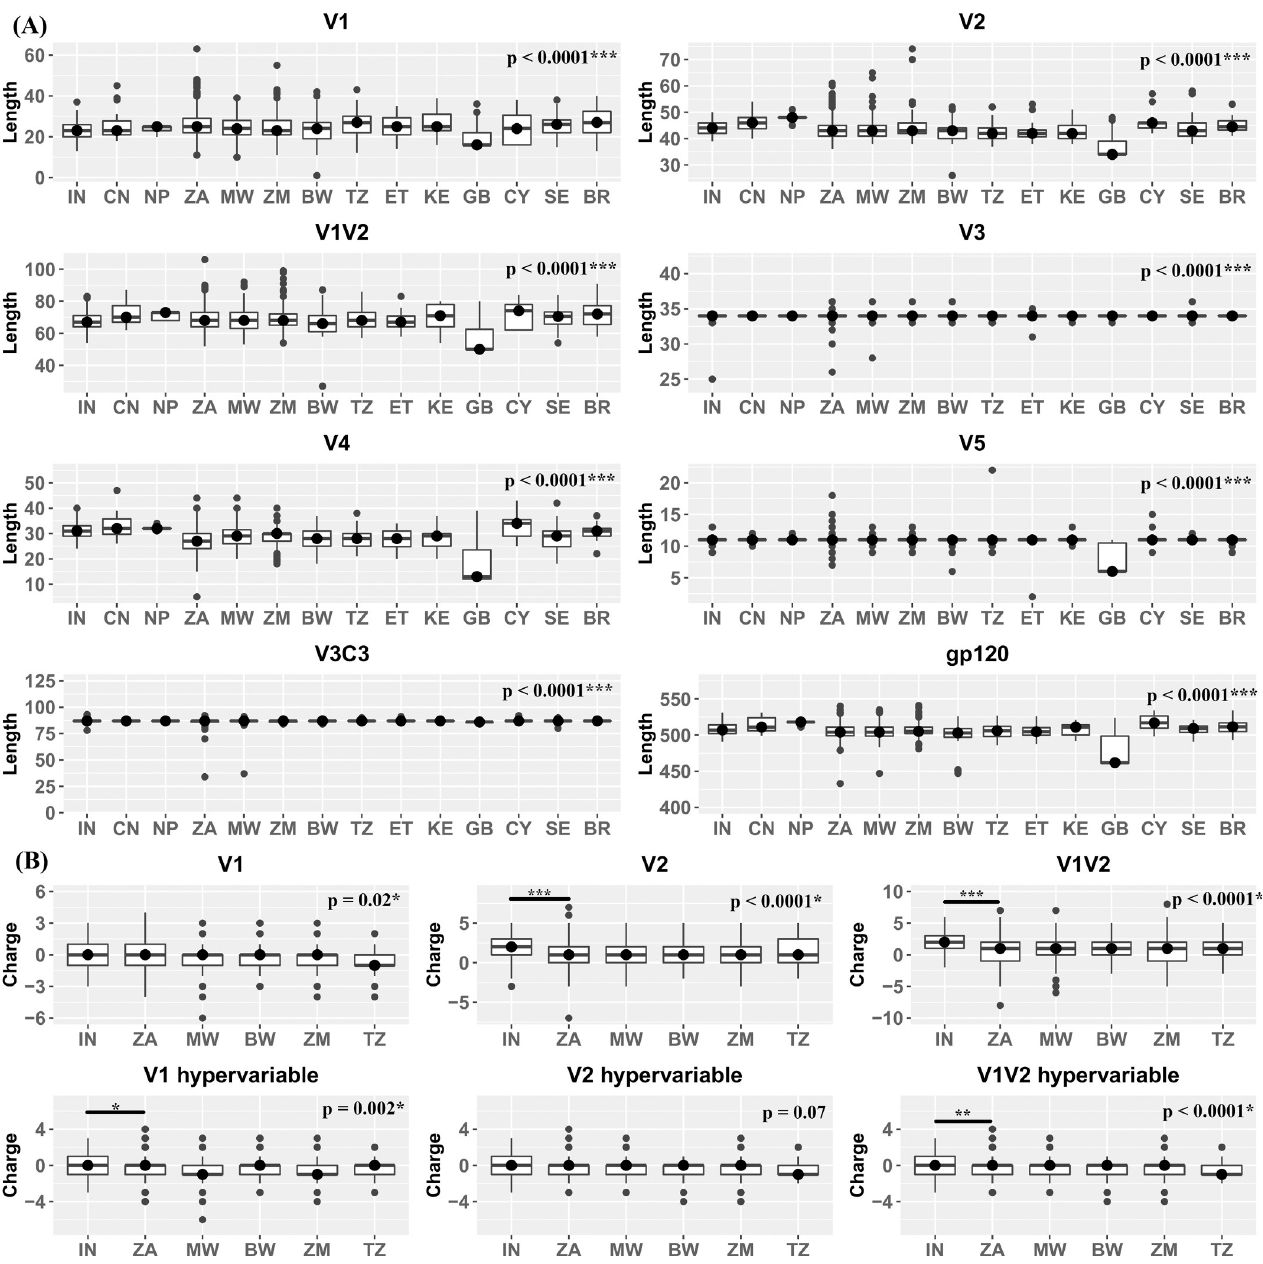
Fig 2. Assessment of Variable region characteristics. A. variable region length: gp120 variable region (V1, V2, V1+V2, V4, V5) as well as entire gp120 lengths have been plotted on the Y axis against the Countries of origin indicated on the X axis. B. Variable region charge: gp120 variable region Charges for V1, V2 and V1+V2 as well as hypervariable regions within them have been plotted on the Y axis against the Countries of origin indicated on the X axis. P values have been indicated following a statistical analysis by Kruskal-Wallis test followed by Dunn’s multiple comparison. differences remained consistent when V1V2 loop were taken together indicating no loop length compensation. The V3 loop length was observed to be highly conserved across all the countries with some outlier values in South Africa. Interestingly, V4 loop length was observed to be most variable among the variable domains. Sequences from UK were observed to have significantly shorter V4 loop (Median: 13) compared to rest of the countries (Median range: